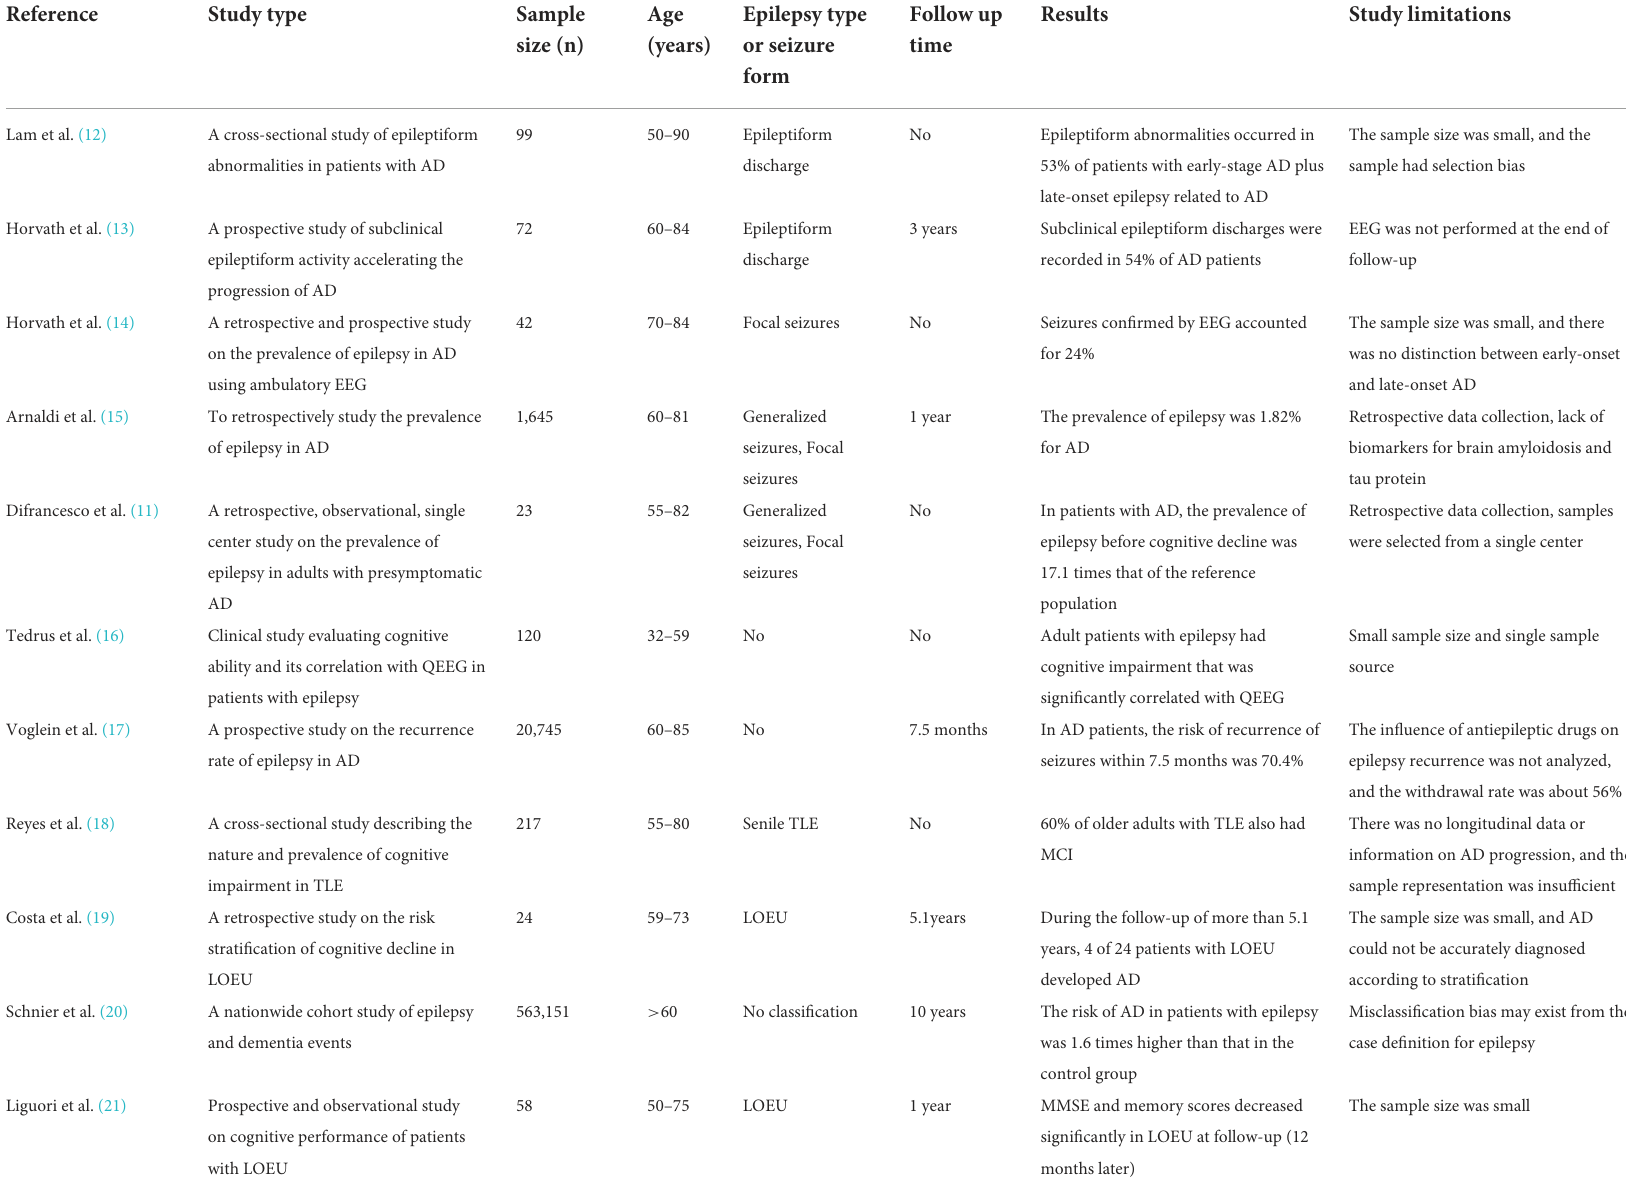
TABLE 1 Summary of clinical studies of AD and